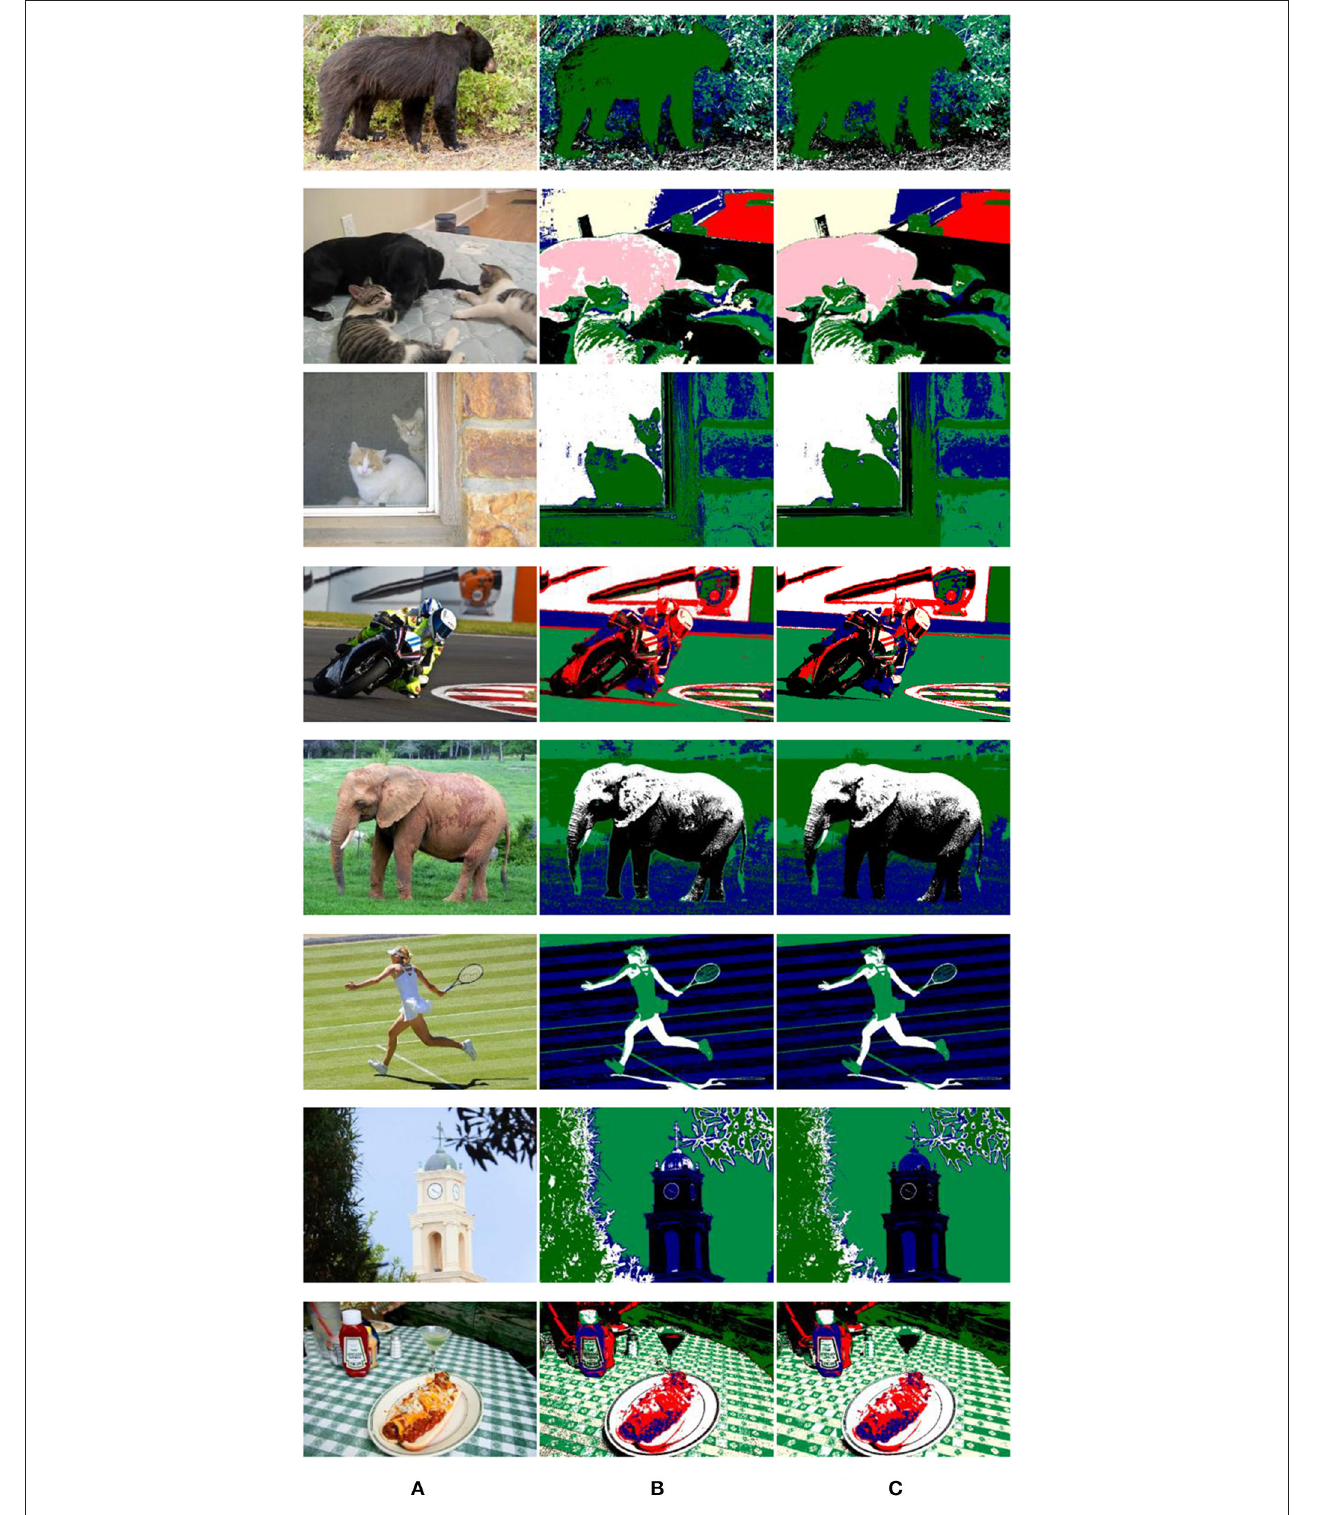
FIGURE 12 | Clustering and optimization results of natural scene pictures. (A) Image: Original. (B) Cluster. (C) Optimization.